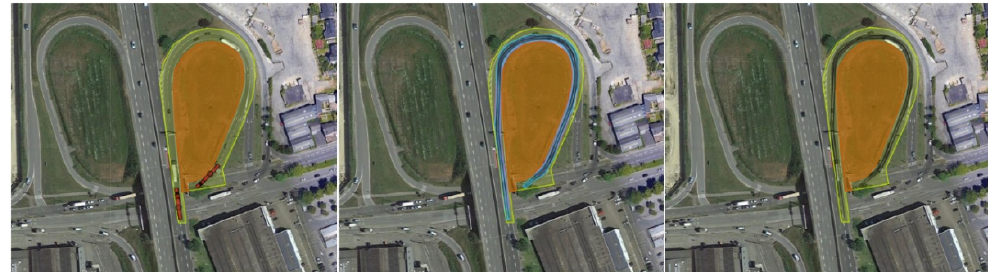
Figure 2. Screenshot from optimization of the long-vehicle route on the exit from the N136 road into the N42, which is the Rennes ring road in France. Source: own study based on the application of HeavyGoods.net (accessed on 18 June 2021). Table 1. Steps of collecting and analyzing collected data with relation to other elements.